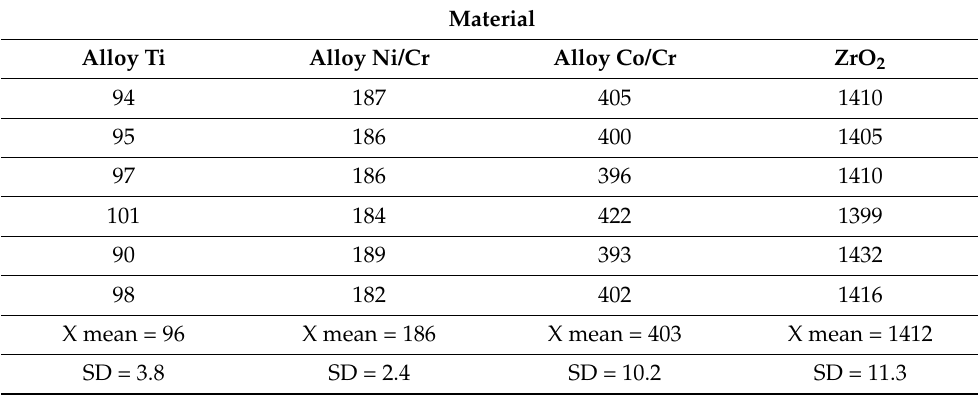
Table 4. HV1 hardness test results of the analysed